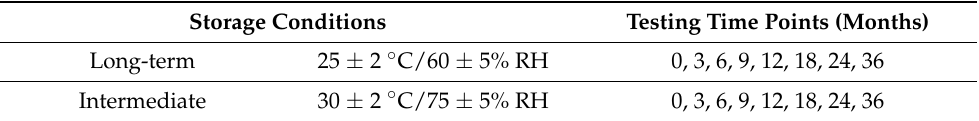
Table 2. Storage conditions and testing